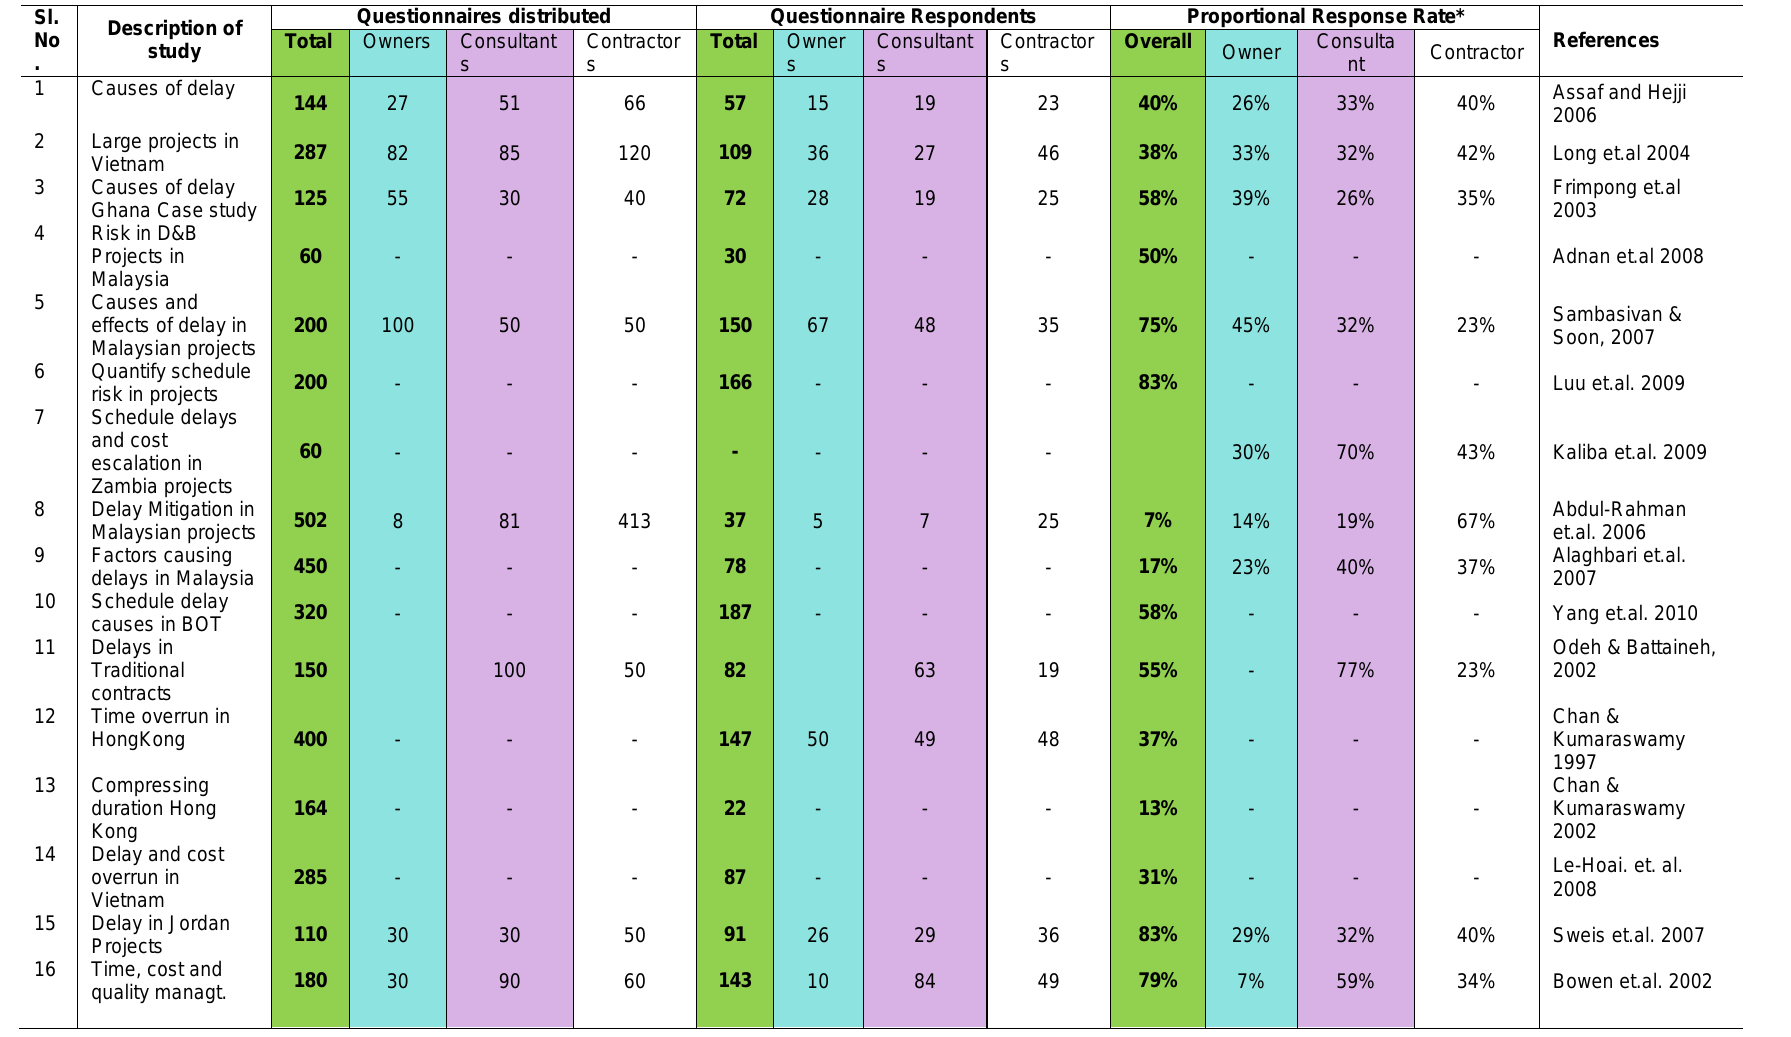
Table 2 Details of the Questionnaire distribution in various studies and their response * The decimals more than 0.5 are rounded to next whole